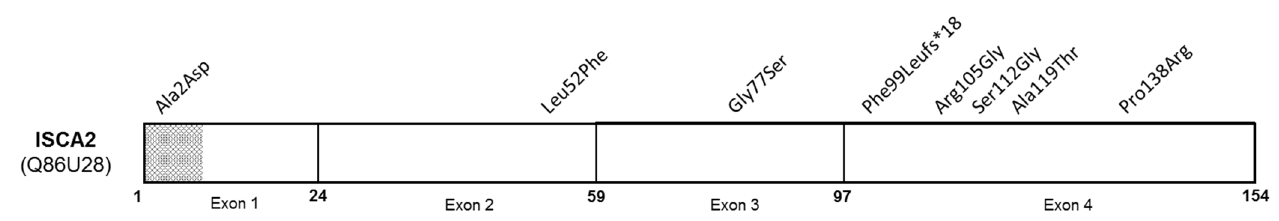
Figure 5. Schematic of ISCA2 protein (NP_919255) with reported pathogenic variants. Mitochondrial target sequencing encompassed residues 1 to 8 (grey and white crosshatches) (adapted from UniprotKB, protein Q86U28).